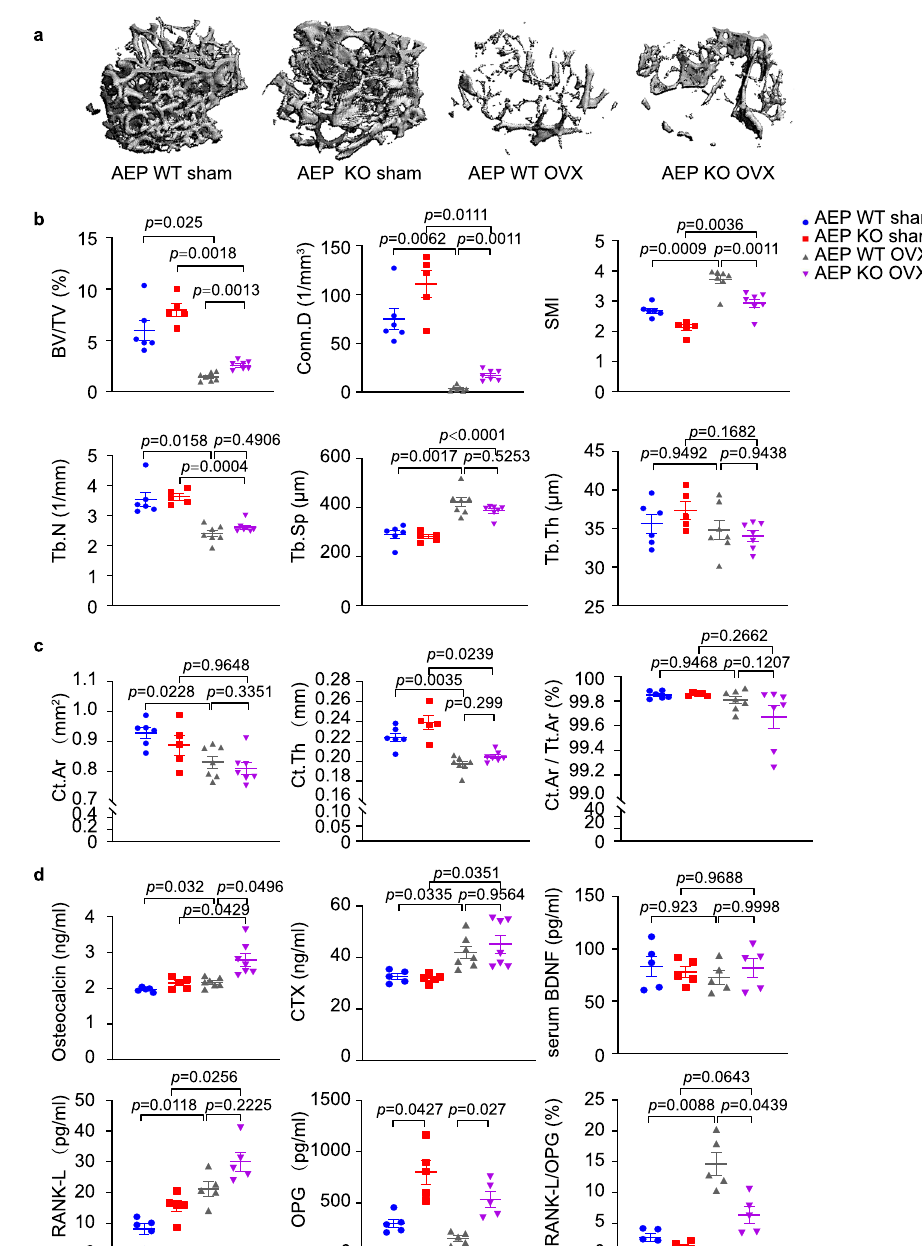
Fig.1|AEPknockoutimprovestrabecularbonedensityinovariectomyfemale mice. Femoral bone structures were assessed by in vitro μ CT in AEP